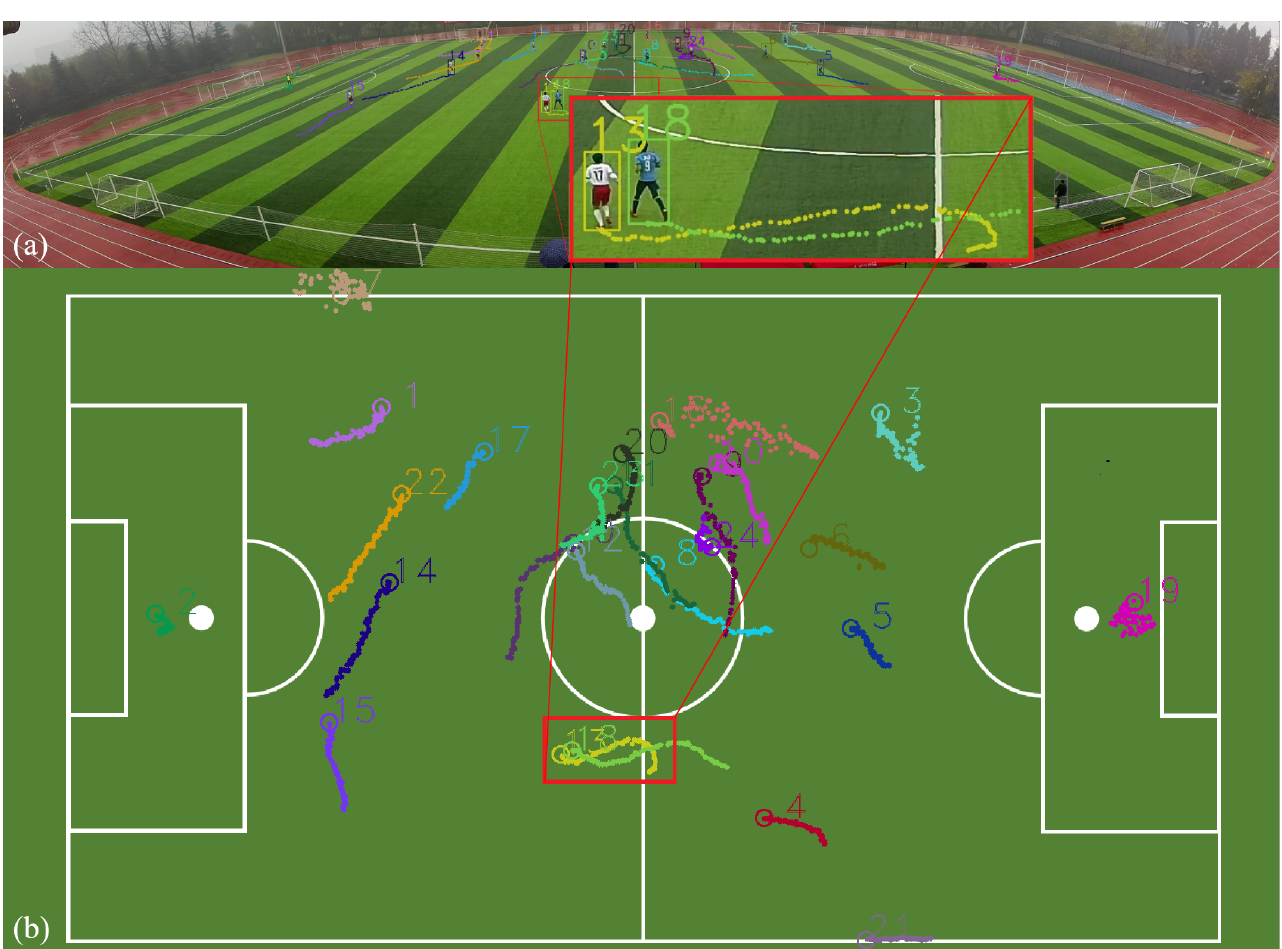
Figure 3. ( a ) is the visualization of players’ motion trajectories in the camera image. ( b ) is the visualization of players’ motion trajectories under the real physical plane. The b-boxes in ( a ) and the circles in ( b ) represent the position of the players at the current moment, and the solid dots depict the trajectories of the players in the past 100 frames. The red boxes marked in ( a , b ) correspond to the trajectories of the same two players in the camera image and the real physical plane